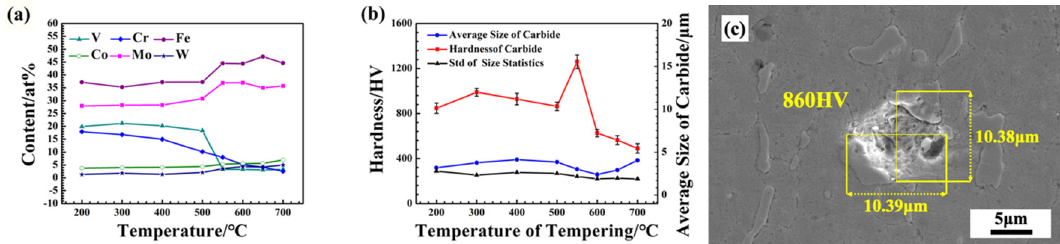
Figure 4. ( a ) Alloy Content of Carbide after Different Tempering Treatments. ( b ) Hardness and Average Size of Carbides after Different Tempering Treatments. ( c ) Microhardness micrograph of M42 after tempering at 500 °C.